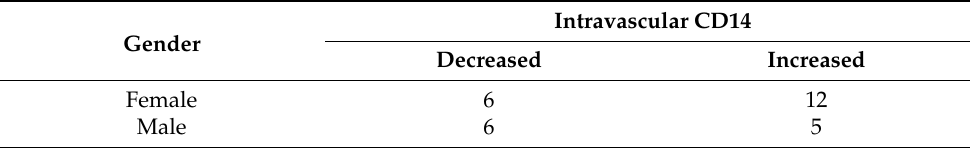
Table 6. Levels of soluble CD14 in females and males of the study group.